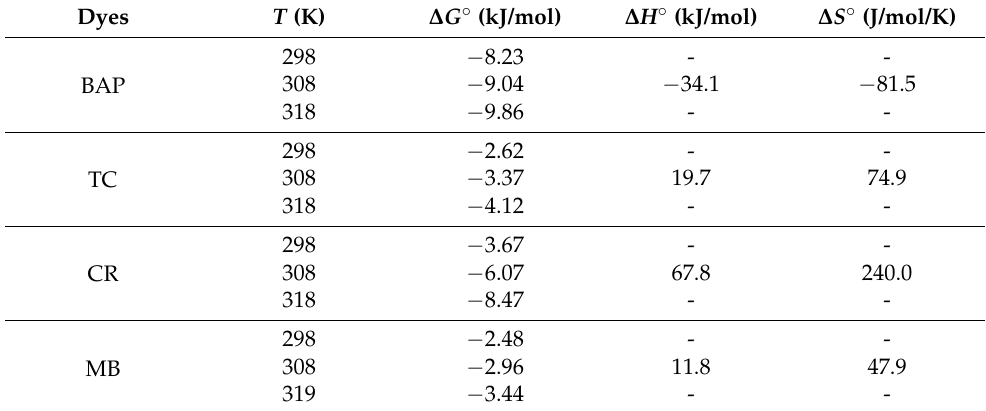
Table 5. Thermodynamic Parameters for BPA, TC, CR, and MB Adsorption on Fe 3 O 4 @MIL-53(Al).